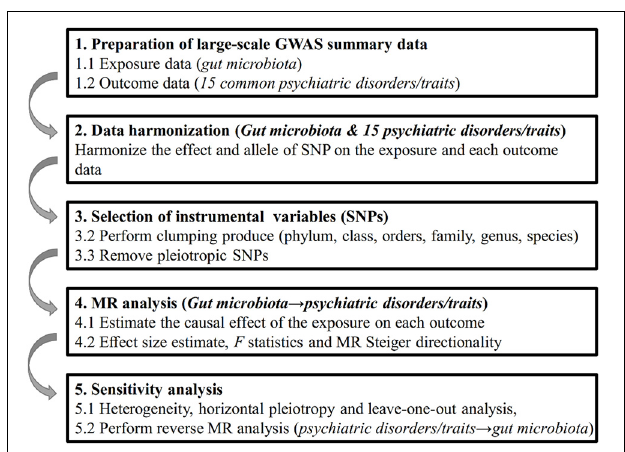
FIGURE 1 | Diagrammatic description of the whole workflow in MR analysis. A flowchart of the whole MR analysis was displayed in this figure.